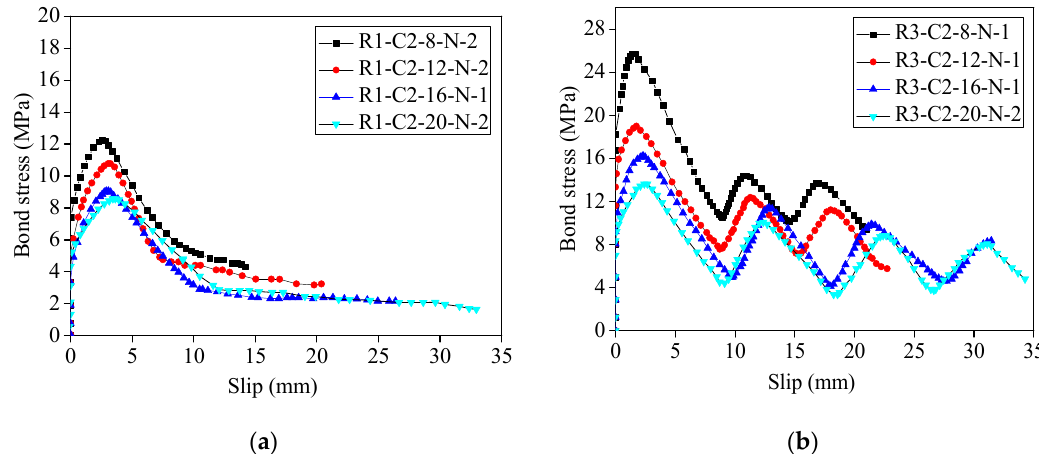
Figure 9. Representative τ - s curves for C2 concrete for the ( a ) R1 bar ( b ) R3 bars.